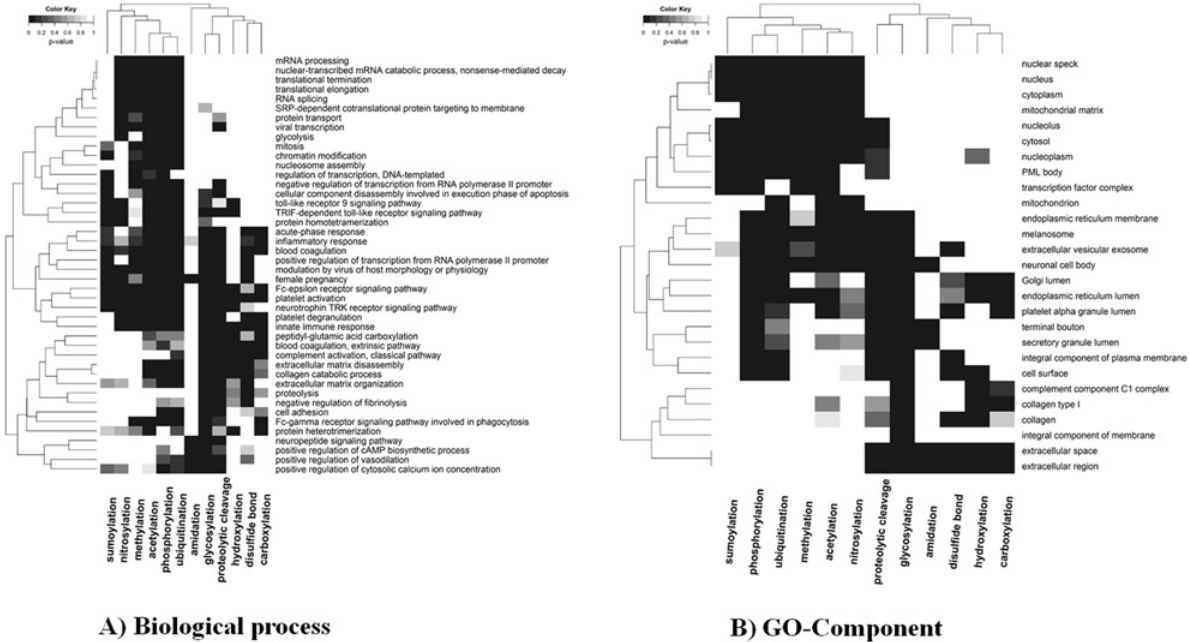
Figure 1. Heatmap of significant A) biological process and B) GO-Component terms across all studied PTM-types. The top five GO-terms were included that were found significantly enriched for each PTM-type. Each element in the heat map (Euclidean distance hierarchical clustering, average linkage) represents the grey-scale-encoded p -value, in which a particular combination of PTM-type and GO-term was found significantly enriched. The combined whole UniProtKB-GOA for all the selected species was used as the background set, Fisher ’ s exact test with FDR correction was used for the enrichment analysis, and the p -value (FDR) threshold indicating significance was set to